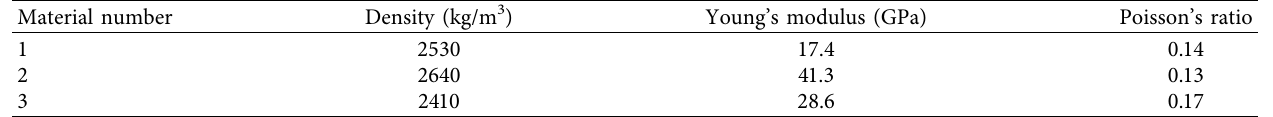
Table 3: The mechanical parameters of the soil layer.